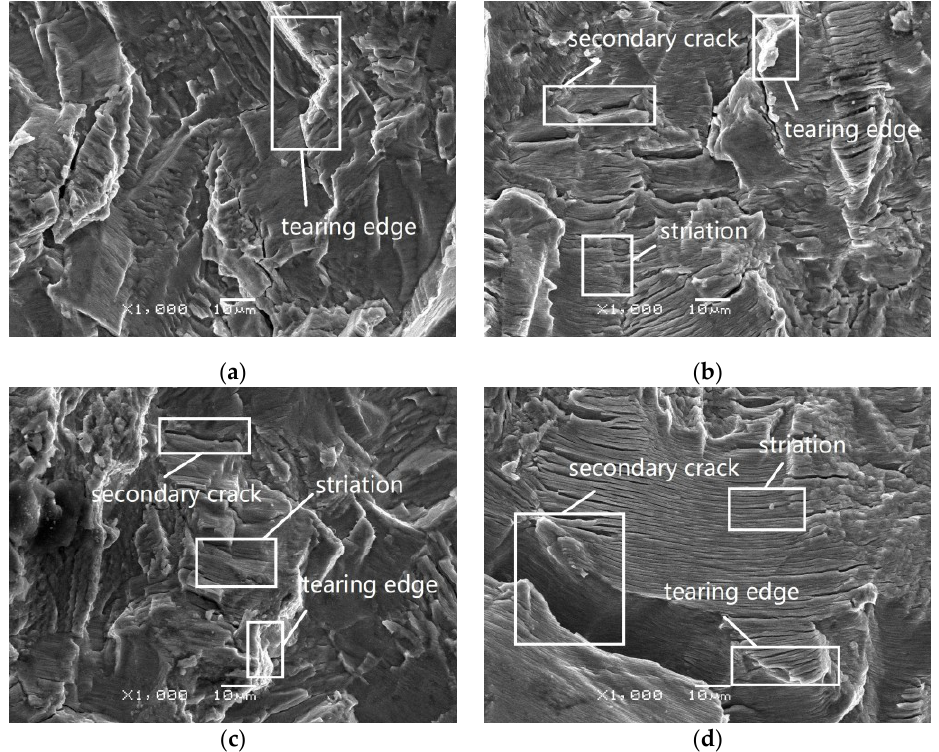
Figure 14. Typical SEM micrographs showing dwell fatigue fracture surface morphology at different temperatures under low load ratio: ( a ) initial stage, room temperature; ( b ) initial stage, T = 300 °C; ( c ) steady stage, room temperature; ( d ) steady stage, T = 300 °C.